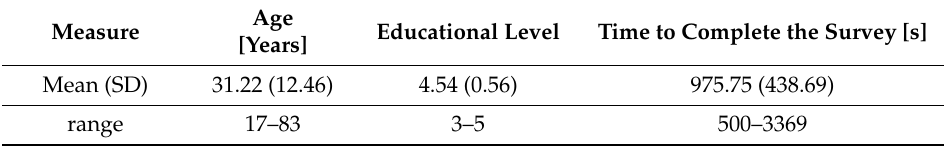
Table 1. Statistics of the demographic data and time on task of N = 273